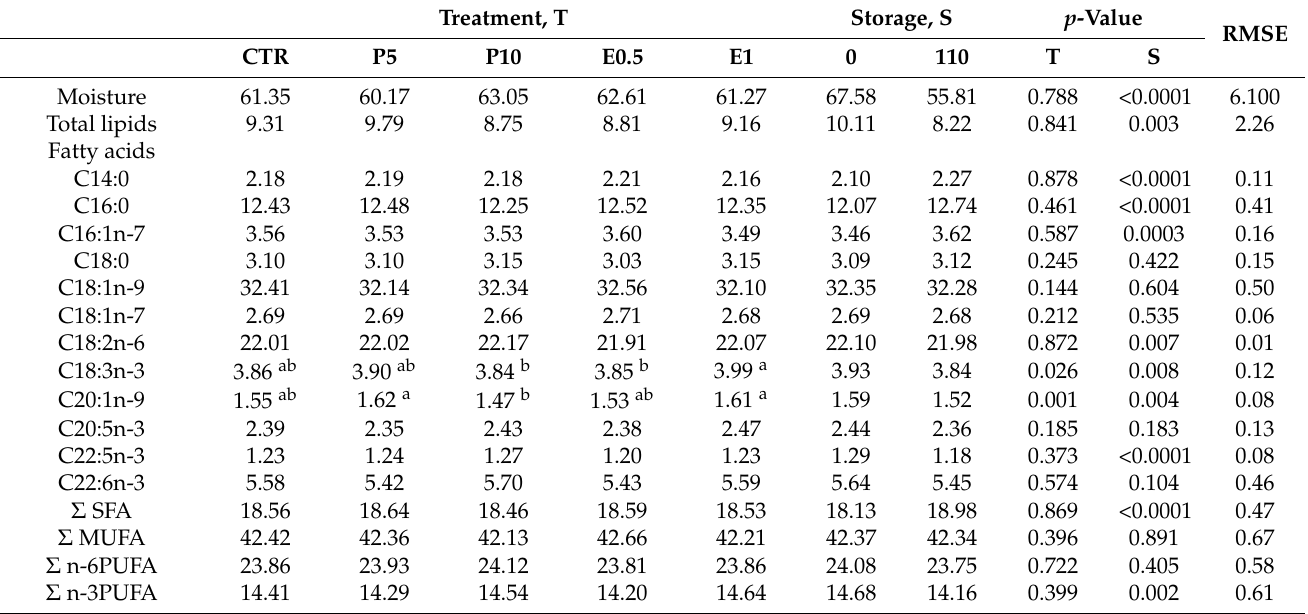
Table 4. Moisture, total lipids (g/100 g of fillet) and fatty acid profile (g FA/100 g FAME) of fillets from gilthead seabream fed the different dietary treatments, analyzed before (day 0) and after 110 days of frozen storage.